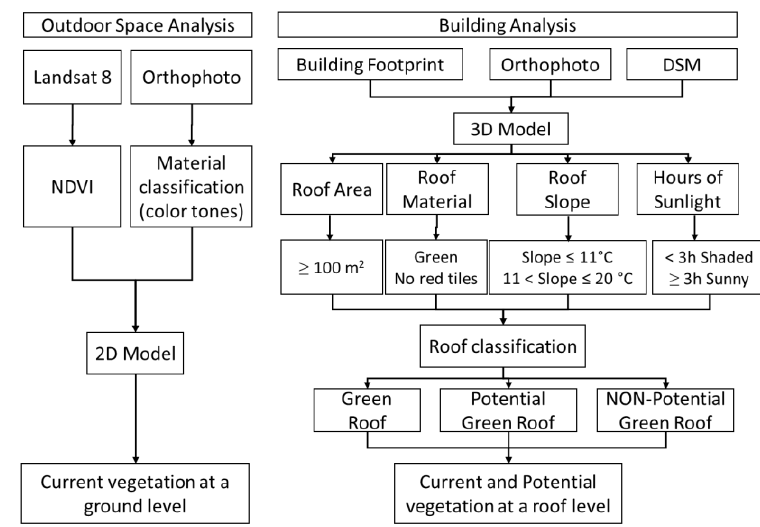
Figure 1. Flowchart of the vegetation analysis: 2D and 3D models.